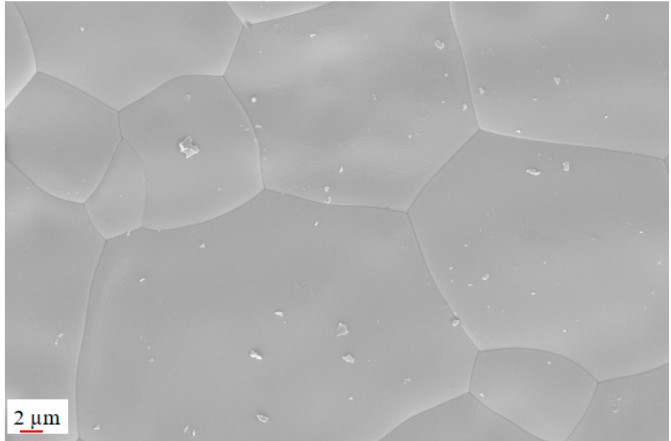
Figure 1. SEM image of a sintered CeO 2 pellet with a grain size of about 20 µm and a relative density of 95%.